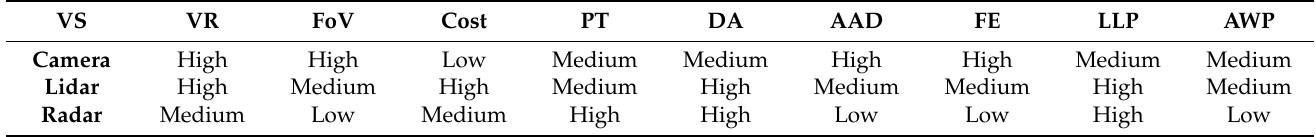
Table 1. Comparison of vision